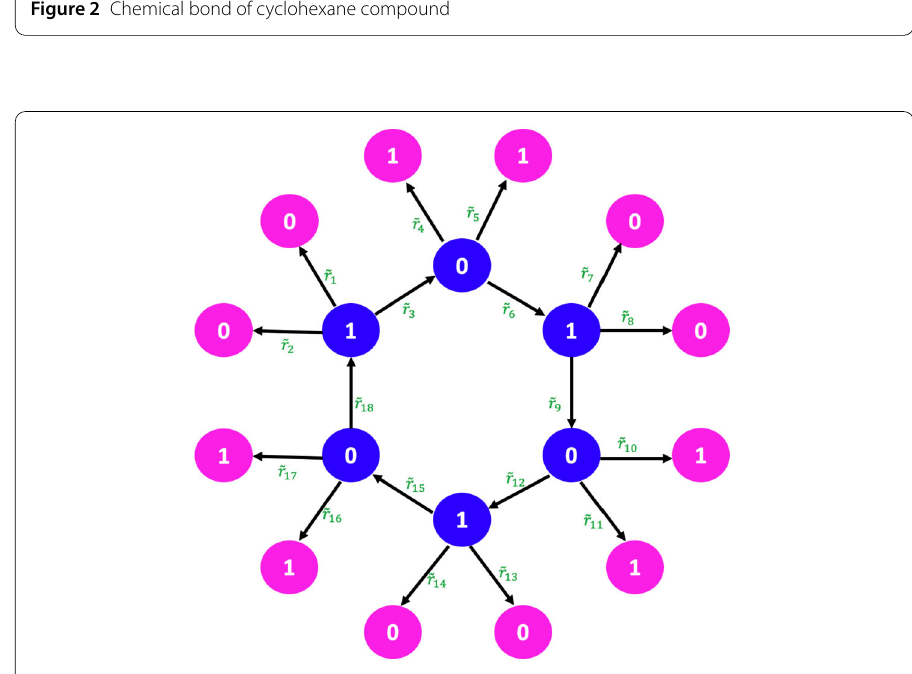
Figure 3 Cyclohexane graph with vertices 0 or 1